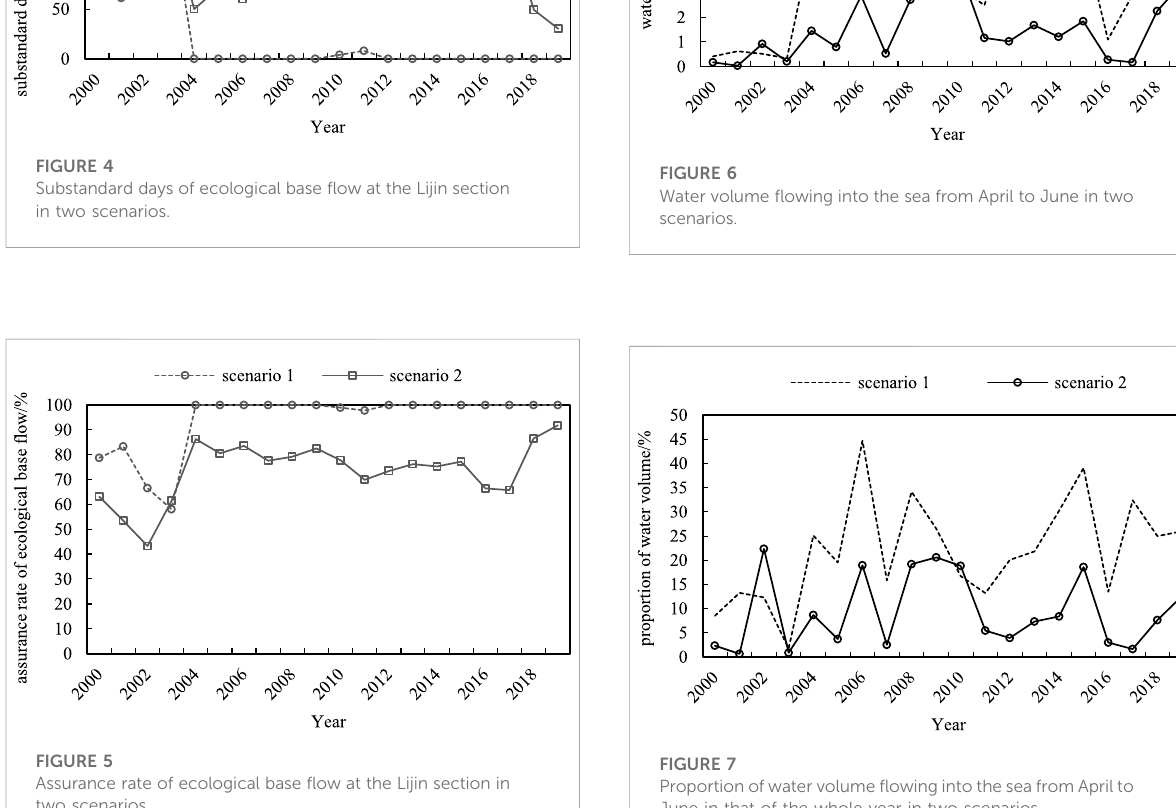
FIGURE 5 Assurance rate of ecological base fl ow at the Lijin section in two scenarios.